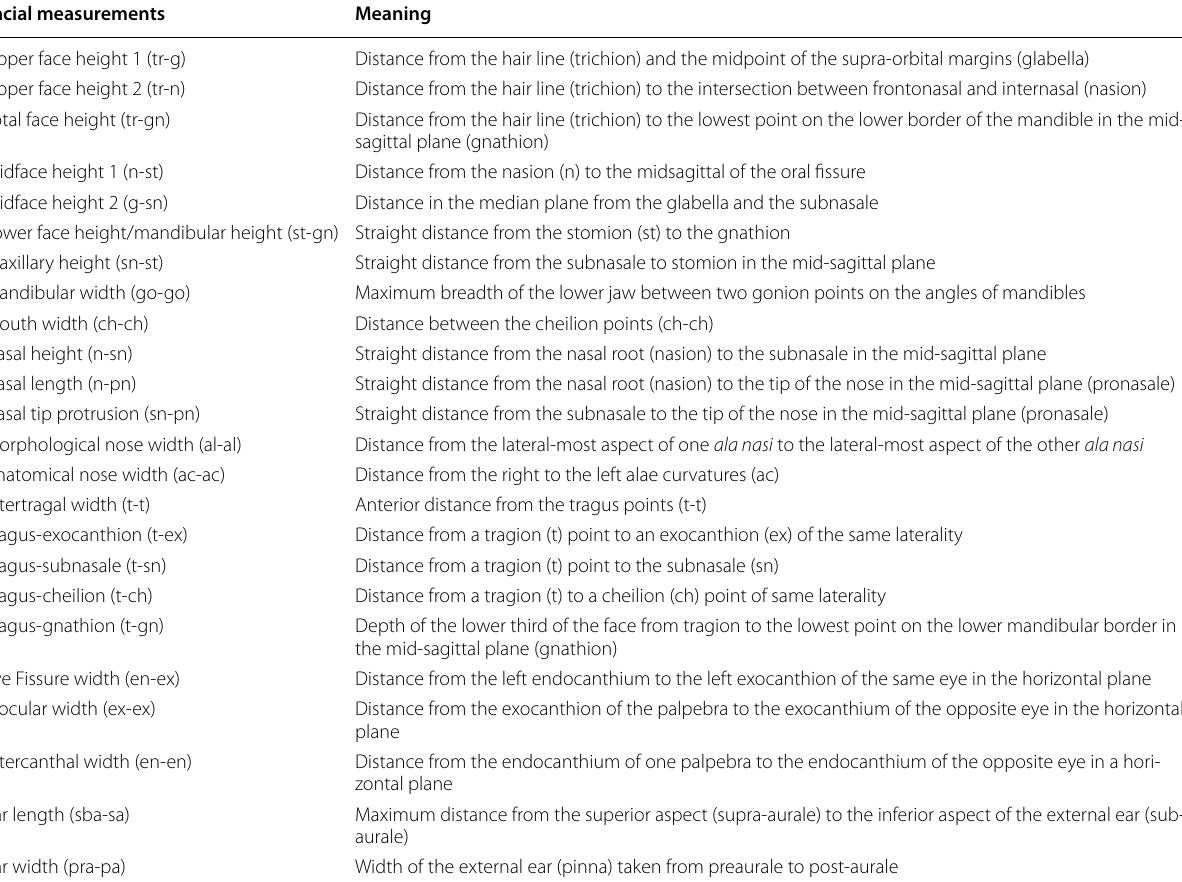
Table 2 Analysis of variance of the upper facial measurements of the Bono and the Ewe participants